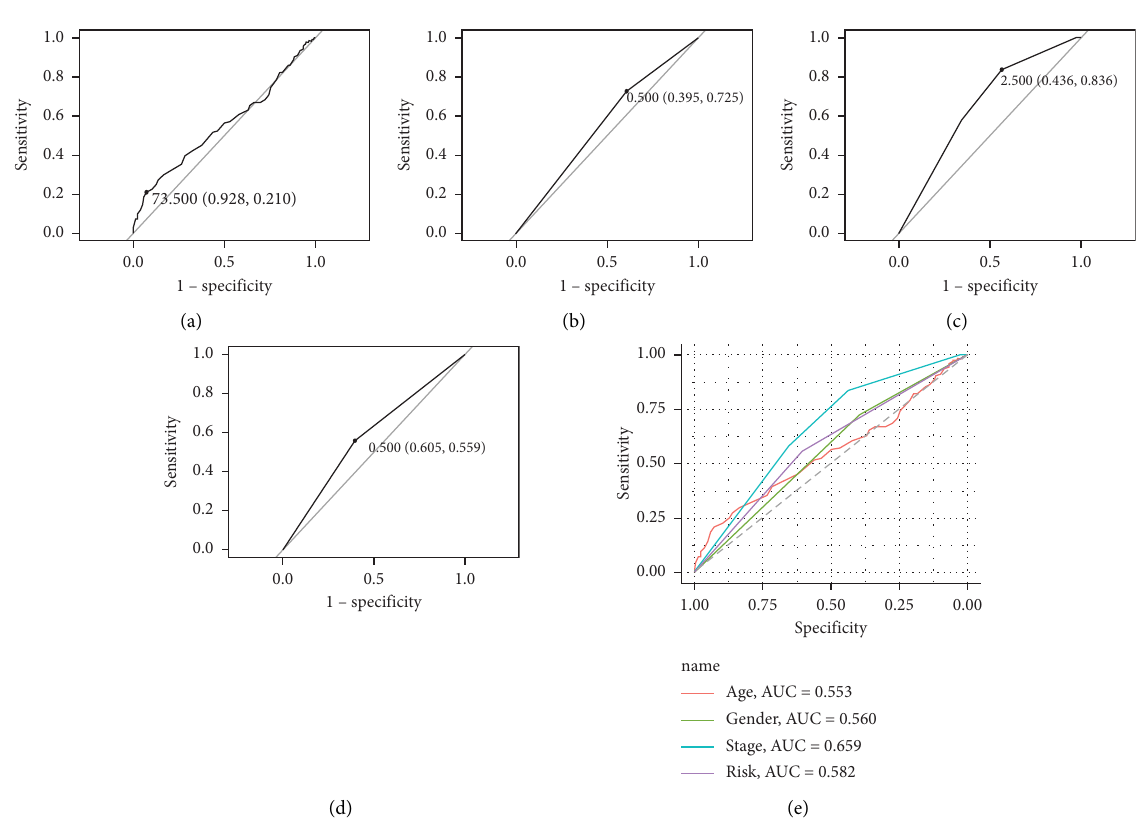
Figure 9: Clinical characteristics and model prediction of survival ROC curve: (a) age; (b) gender; (c) stage; (d) risk group; (e) all characteristics and